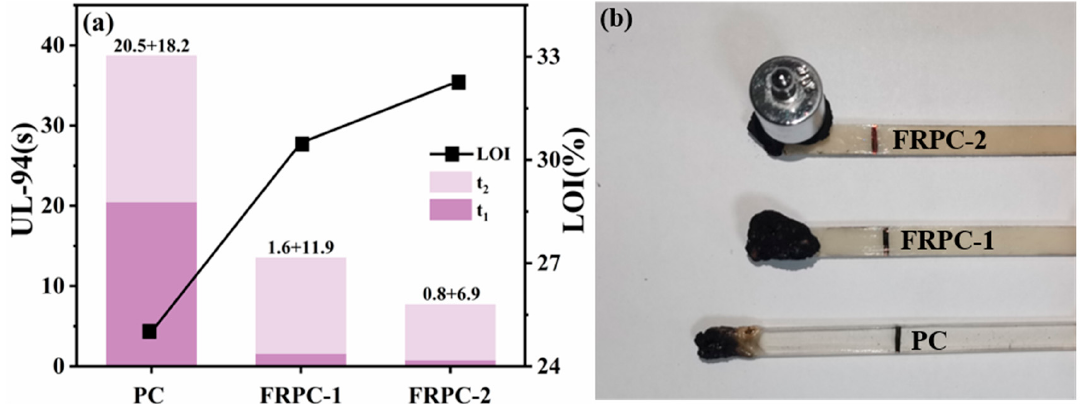
Figure 2. Flame retardancy ( a ) and digital photographs of char residues ( b